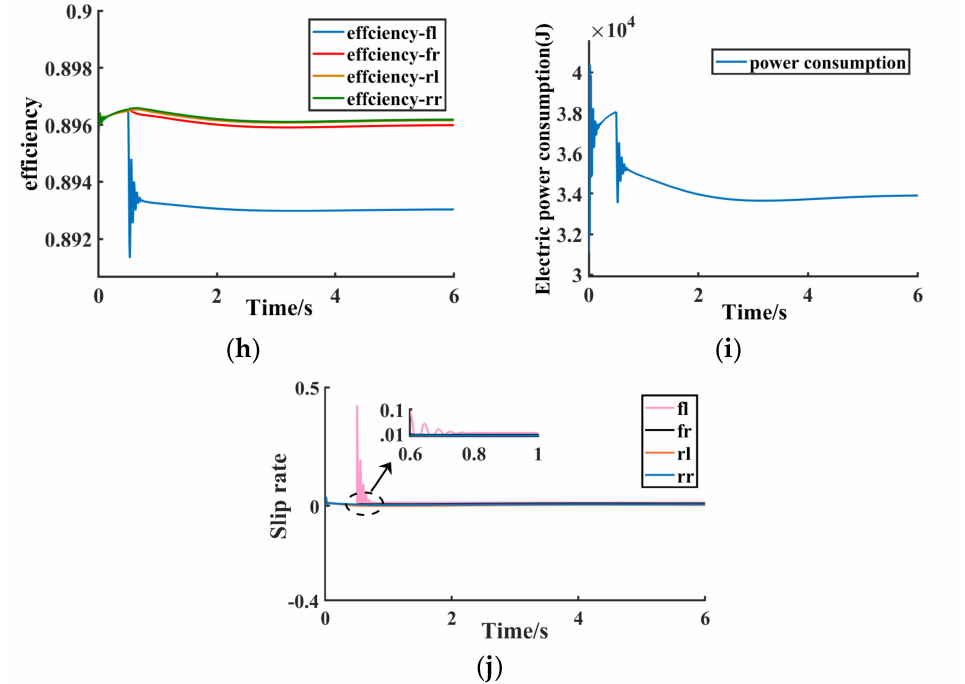
Figure 6. Constant speed turning condition. ( a ) Vehicle front wheel turning angle. ( b ) Vehicle speed and target vehicle speed. ( c ) Driving torque of the wheels. ( d ) Vehicle center of mass side slips angle. ( e ) Vehicle yaw rate. ( f ) rl, rr error. ( g ) fl, fr error. ( h ) Motor efficiency. ( i ) Electric power consumption. ( j ) Wheel slip